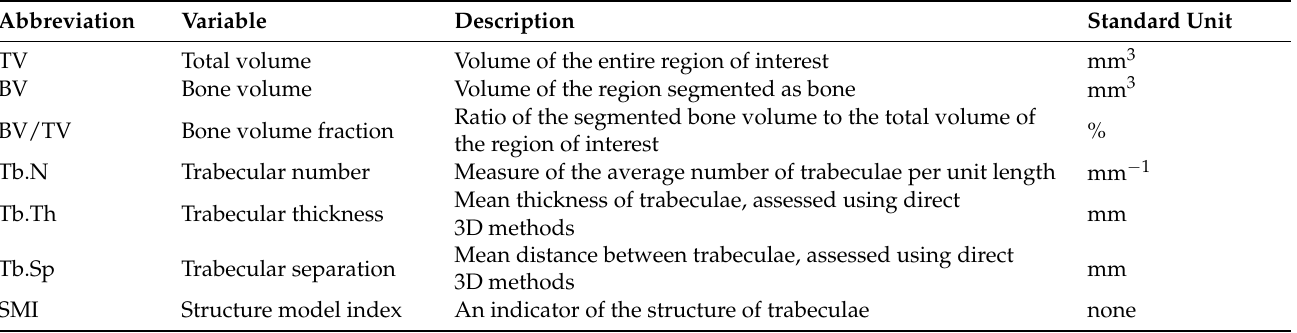
Table 1. Trabecular bone parameters for the microarchitecture assessment